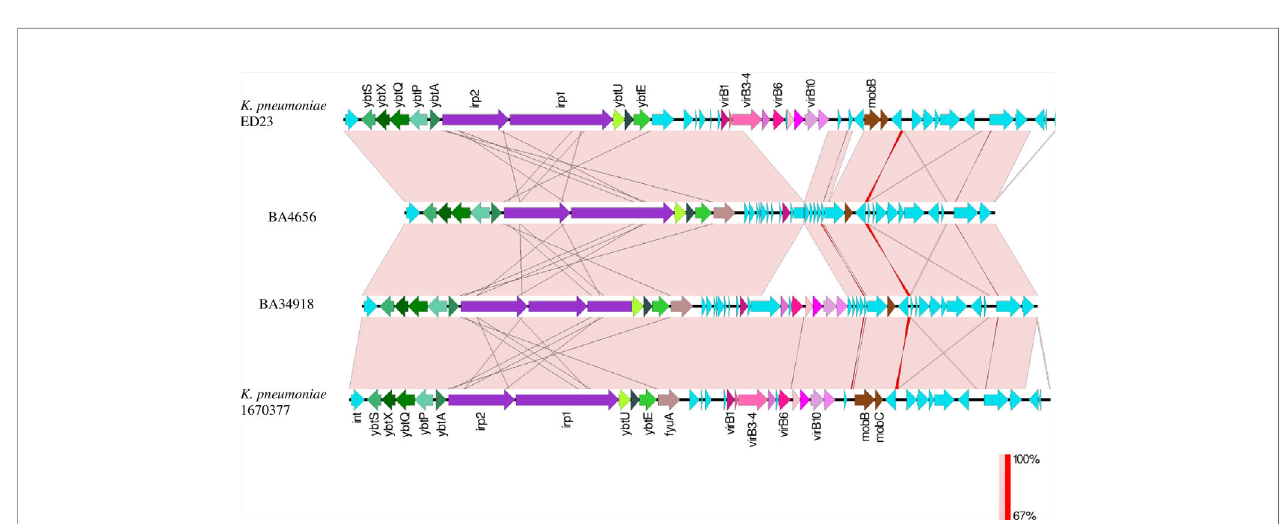
FIGURE 5 | Comparison between ICEKp3 genomic islands (GI) of hypervirulent (hv) Klebsiella pneumoniae isolates BA4656 and BA34918 with ICEKp3 GI from other K. pneumoniae strains ED23 and 1670377. This island contains the yersiniabactin gene cluster and the type IV secretion system (T4SS) virB gene cluster. ICEKp3 of BA4656 was shorter than BA34918 since it lacked some of the T4SS